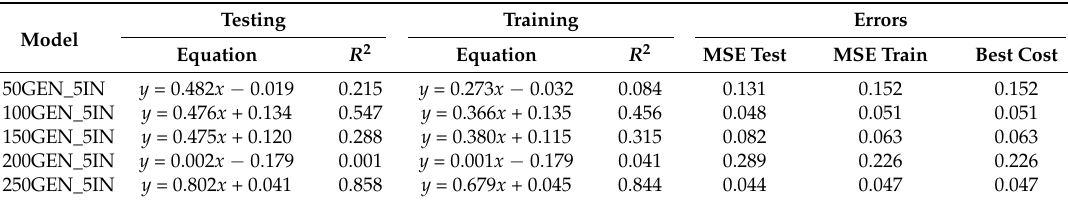
Table 4. Results of testing and training of the ICA-ANN.